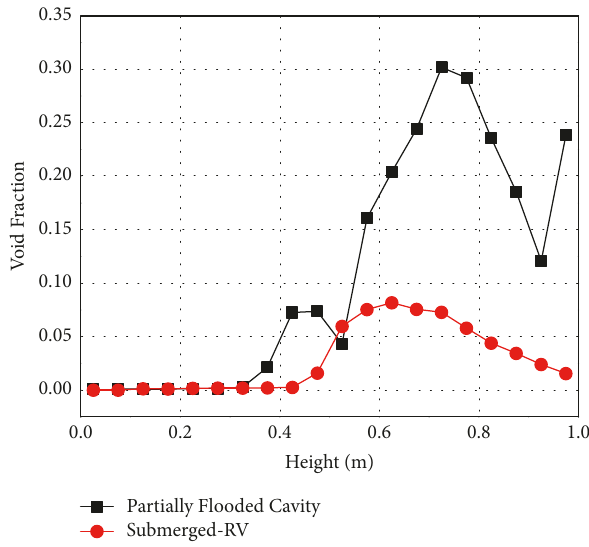
Figure 13: Axial distribution of void fraction at the triggering time in both